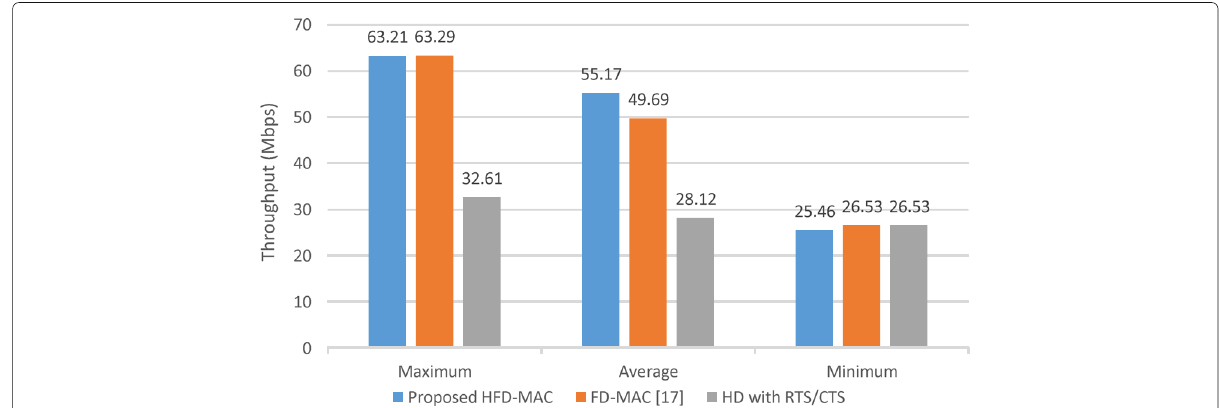
Fig. 14 Throughput comparison for 20 nodes